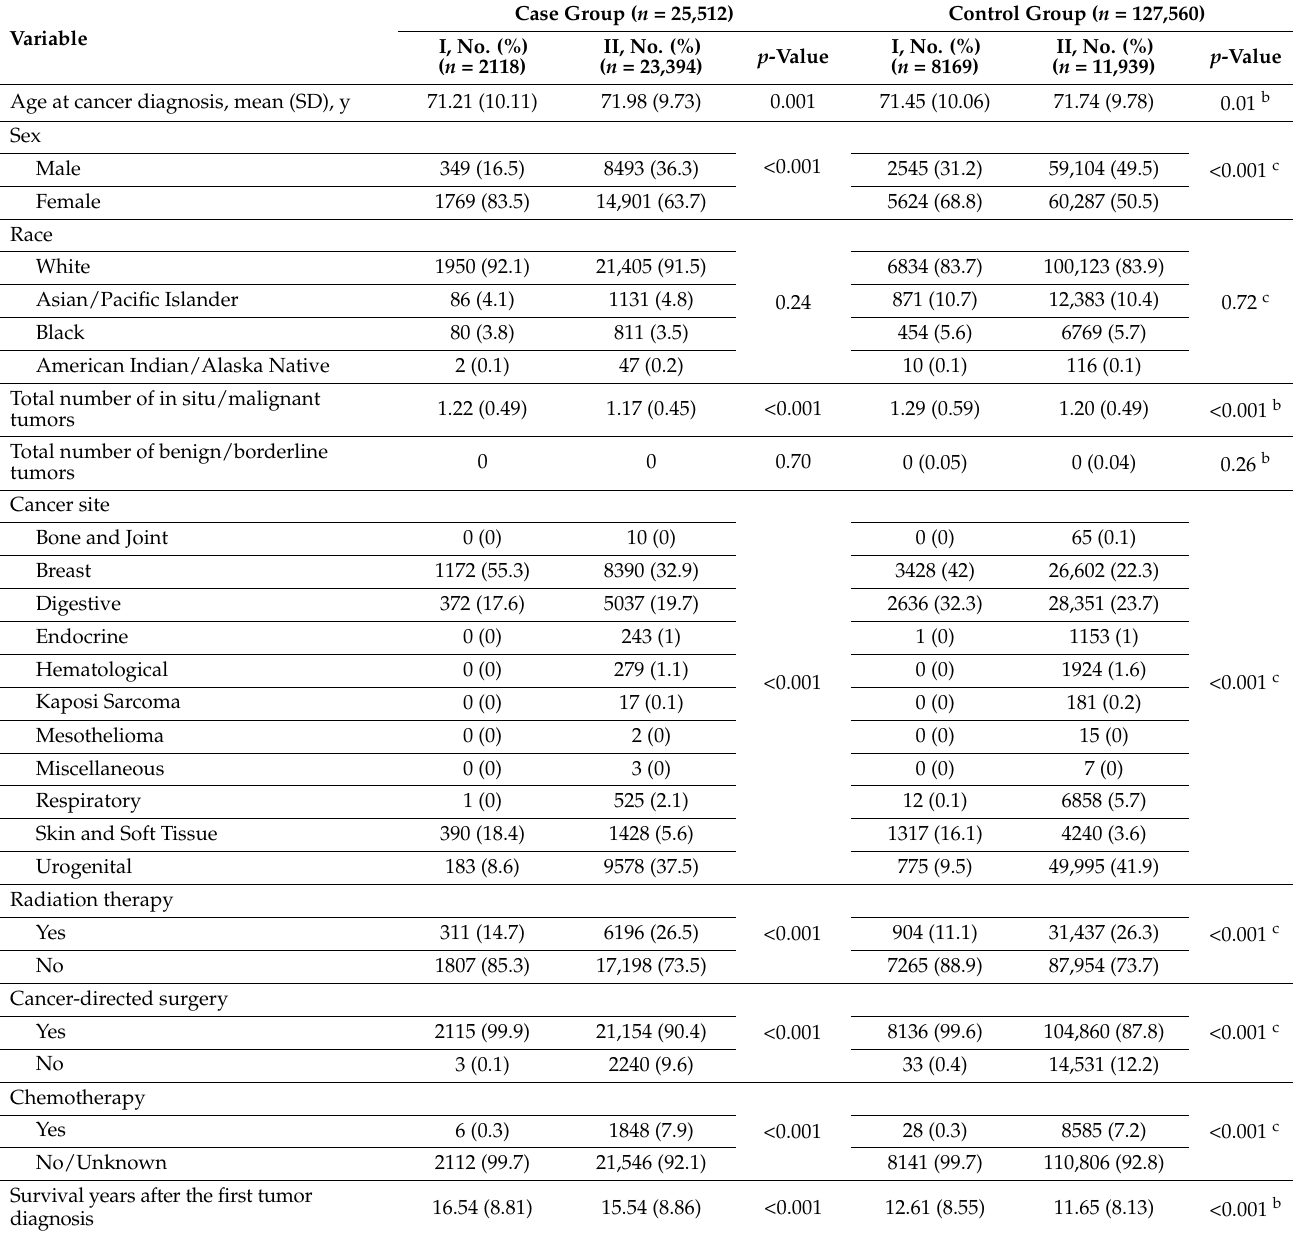
Table 3. Sample Characteristics Stratified by Pain Rating a